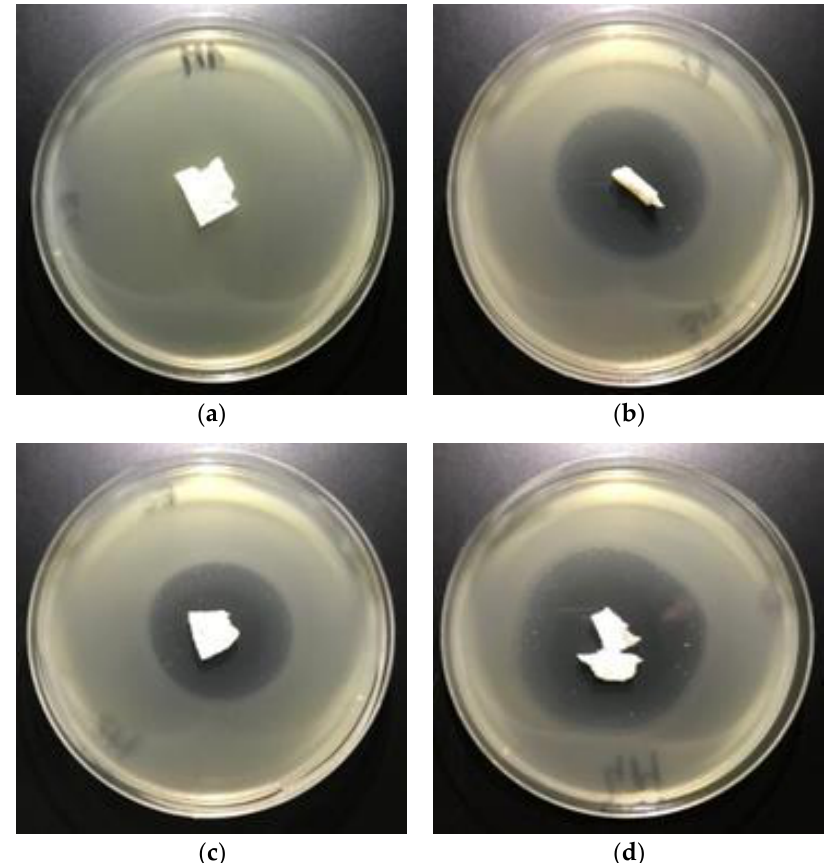
Figure 8. The nonwovens antimicrobial activity tests against E. coli. Inhibition zones of bacterial growth on Petri dishes, modified PLA nonwoven with fosfomycin coating pastes concentrations: a —0%; b —0.005%; c —0.01%; d